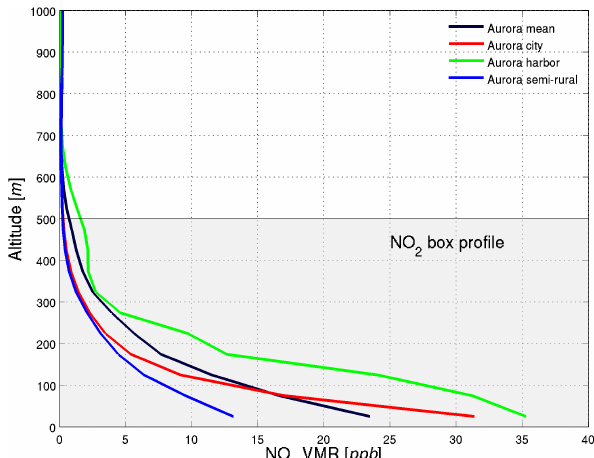
Figure 11. Representative AURORA a priori NO 2 profiles used for the Antwerp data set RTM calculations. A simple NO 2 box profile of 500m height which is well-mixed in the boundary layer is also used in the sensitivity